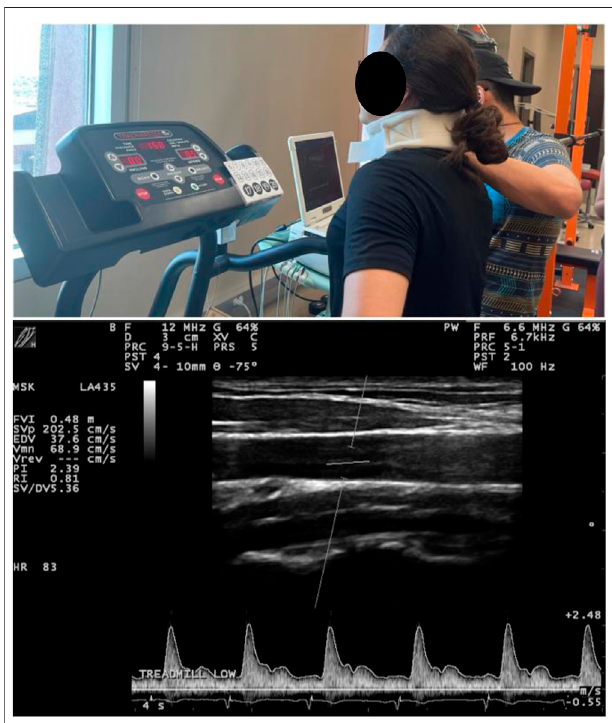
FIGURE 2 | Typical ultrasound testing setup with neck probe holder utilized during all exercise testing and representative ultrasound